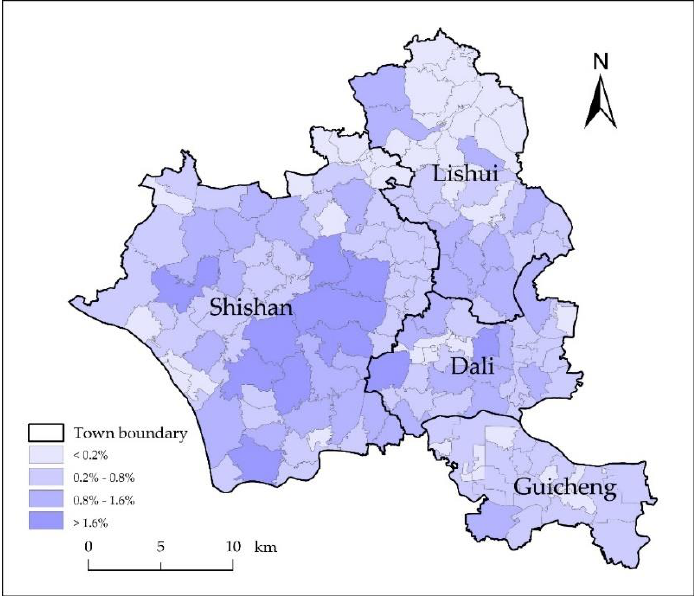
Figure 9. Proportion of blue steel roofs area to total blue steel roofs area.